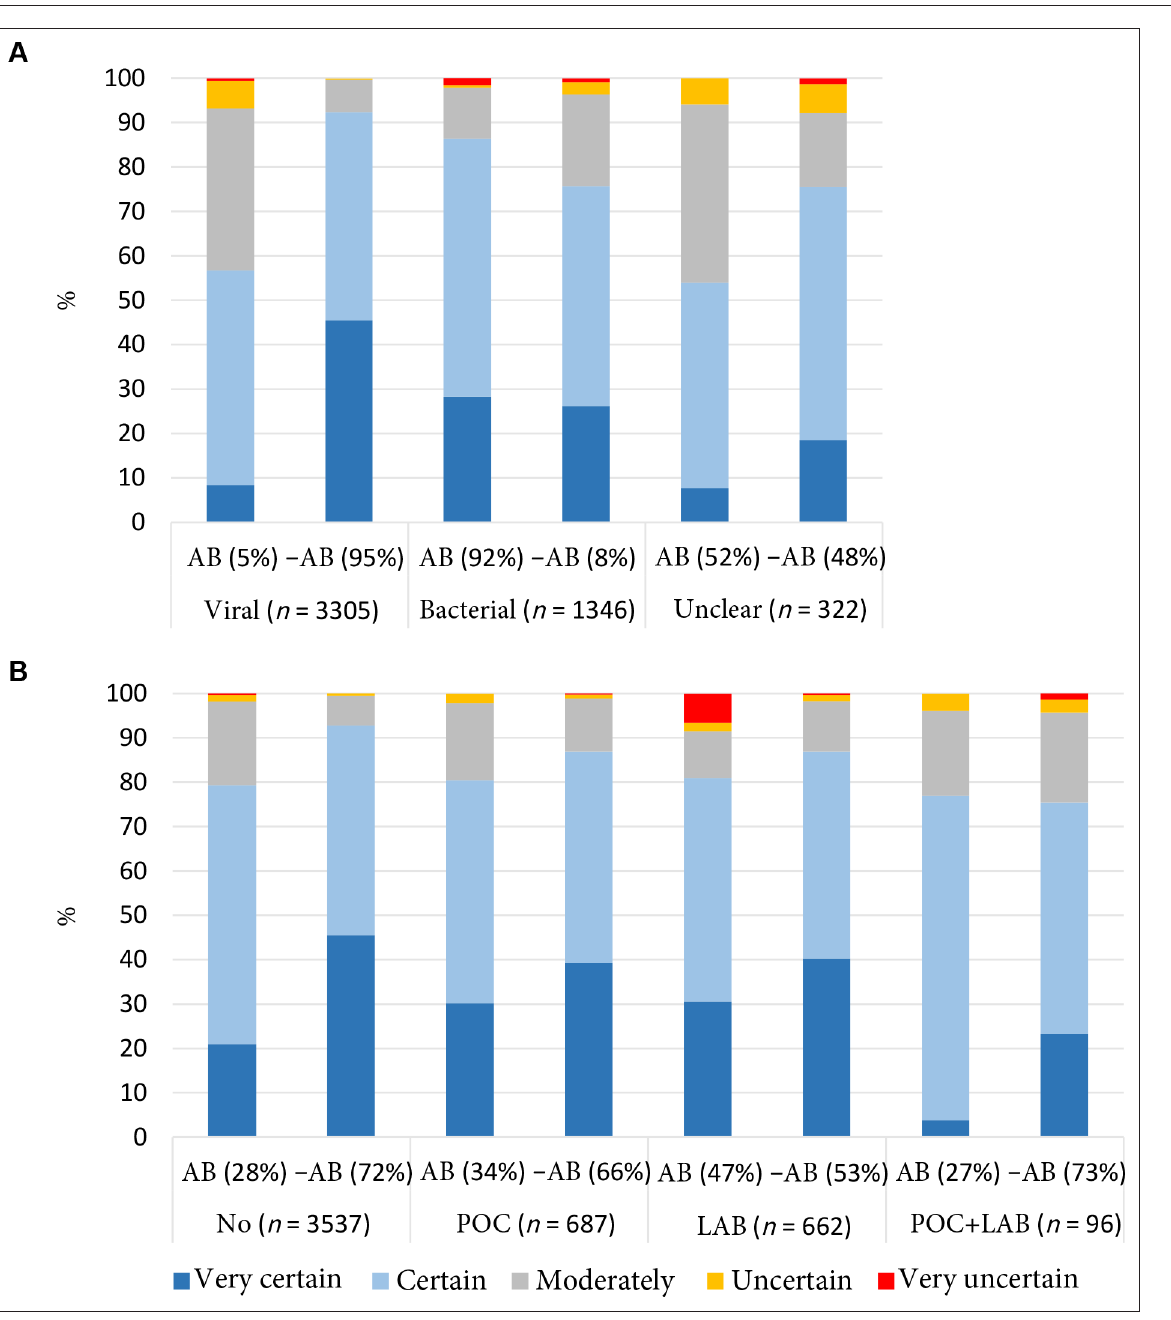
Figure 2 Percentages of consultations by level of confidence in the antibiotic prescribing decision; A) split by suspected viral, bacterial, and unclear aetiology; and B) split by testing group. AB = antibiotic prescribed. –AB = no antibiotic prescribed. POC = point- of- care. LAB = laboratory or hospital- based. POC+LAB = point- of- care plus laboratory or hospital-